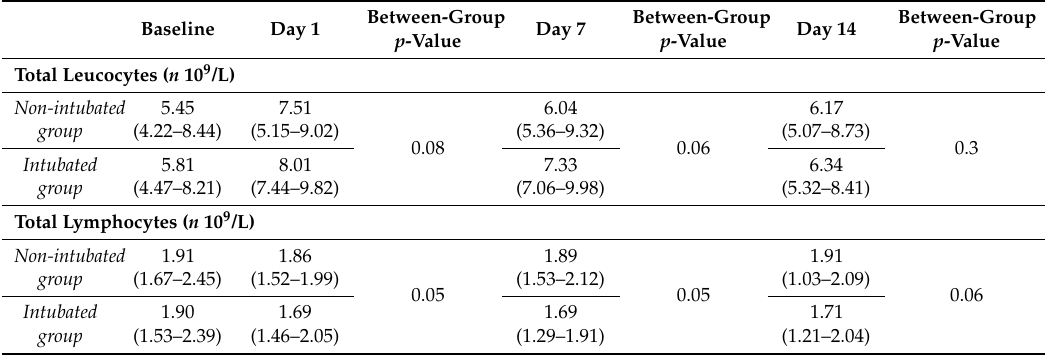
Table 2. Postoperative changes of lymphocyte subpopulations. Interquartile ranges are expressed within